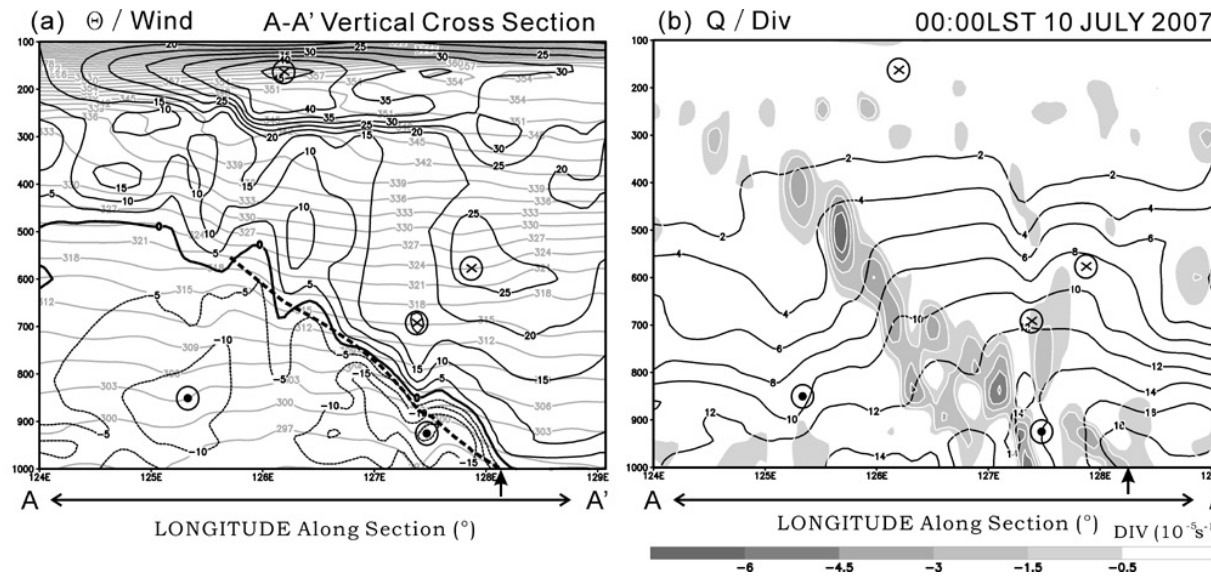
Fig. 5. Vertical cross-sections from 124 ◦ E, 41 ◦ N to 129 ◦ E, 33 ◦ N (line A–A 0 in Fig. 4b): (a) potential temperature θ (K, grey line) and horizontal wind component normal to section plane (ms − 1 , solid for positive, dashed for negative and thickened for zero); and (b) divergence (10 − 5 s − 1 , shaded) and mixing ratio q (gkg − 1 , contoured) between 1000hPa and 100hPa. The arrows represent the location of the surface front. The thick dotted lines indicate the frontal zone. Crossed circles ( ⊗ ) denote the positive wind direction into the page, and dotted circles ( (cid:12) ) denote the negative wind direction out of the